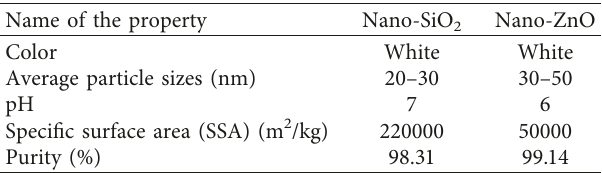
Figure 2: SEM microstructure and particle size of nanospheres: (a) nano-SiO Table 5: Selected properties of studied nanospheres. Name of the property Nano-SiO 2 Nano-ZnO